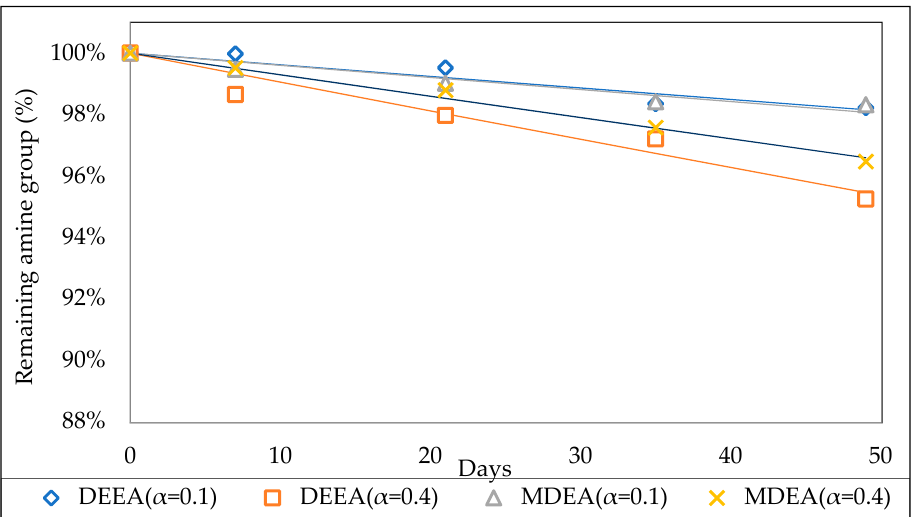
Figure 12. Remaining amine group (%) in various aqueous amine solutions, with solid lines representing the model results; unloaded amine wt.% = 30.